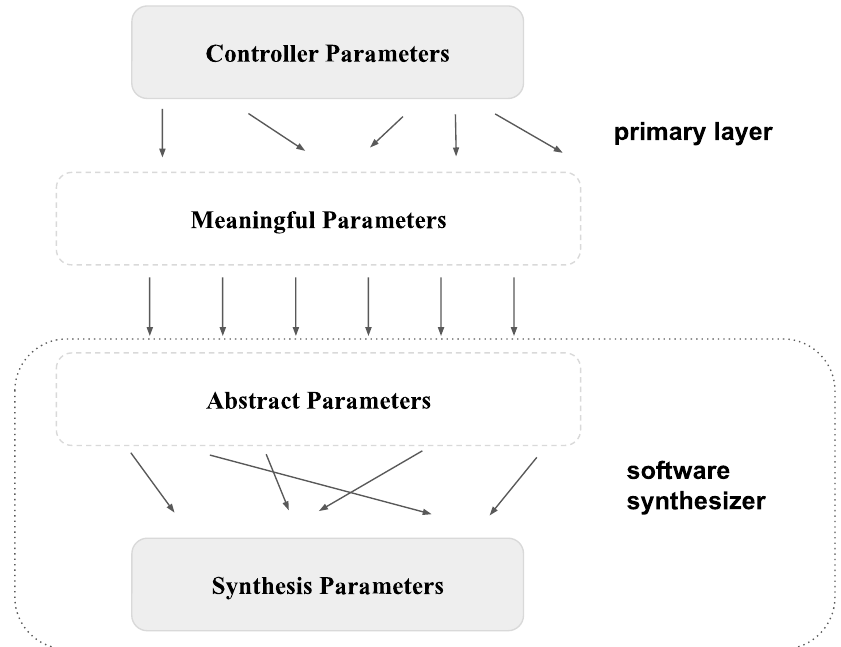
Figure 1. Hunt et al.’s three-layer mapping model [20]. Raw sensor parameters are mapped to ‘meaningful’ gestural parameters, which are mapped to ‘abstract’ synthesis parameters, which are mapped to raw synthesis